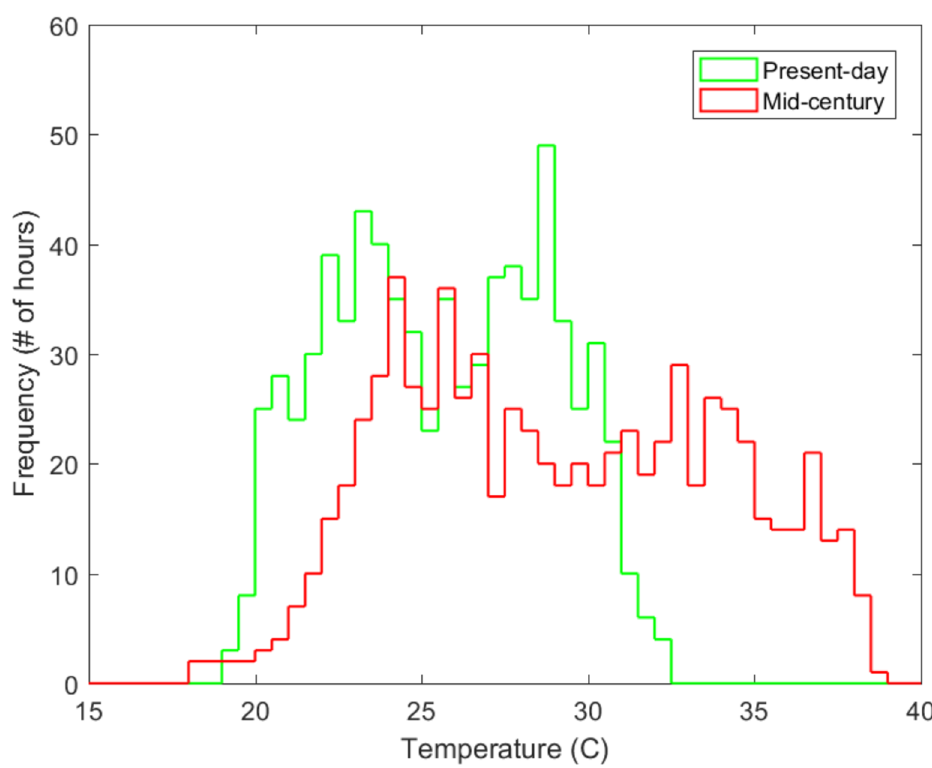
Fig 2. A histogram of regional average hourly temperatures. A histogram of regional average hourly temperatures is presented for July in the present-day and in the warm mid-century climate. Present-day mean: 25.6 ˚C; minimum: 19.1 ˚C; maximum: 32.4 ˚C. Mid-century mean: 29.1 ˚C; minimum: 18.3 ˚C; maximum: 38.5